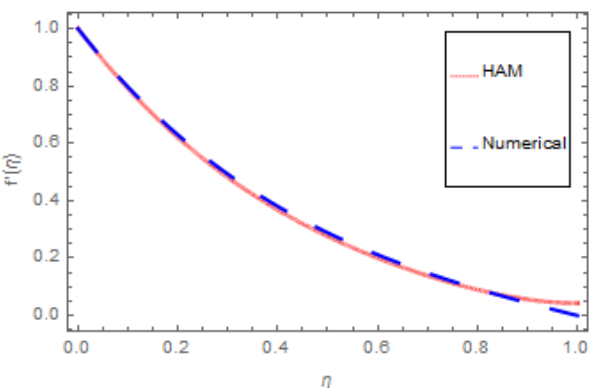
Figure 8. The assessment of HAM and ND-Solve for f (cid:48) ( η ) .